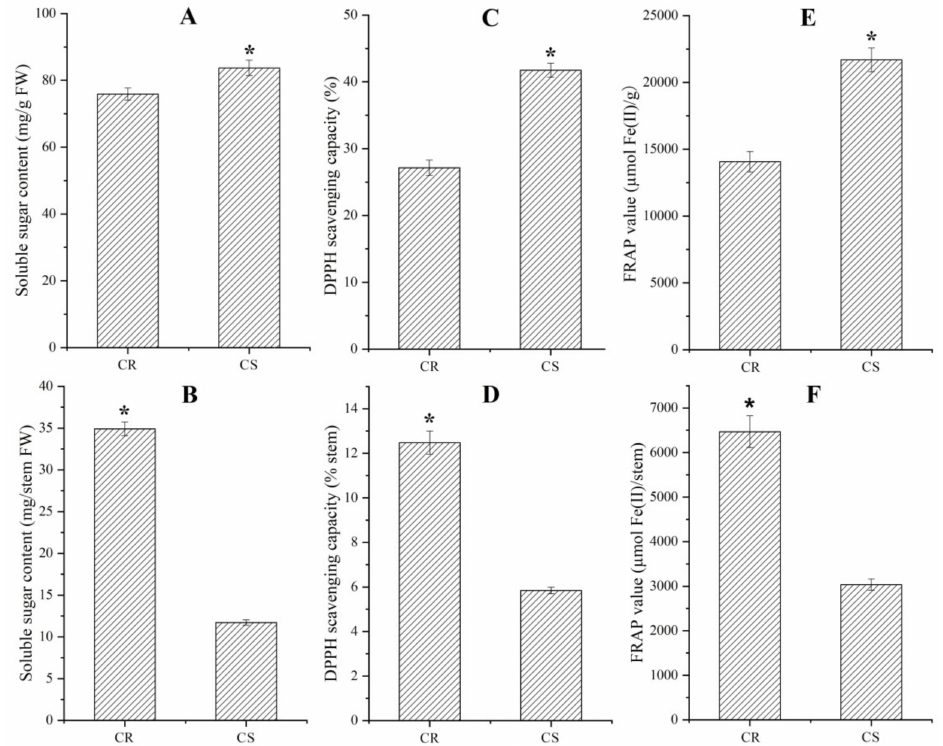
Figure 2. Soluble sugar content and antioxidant capacity in stems between the CR and CS (mean ± SD, n = 20). Images ( A – D ) as well as ( E , F ) represent soluble sugar content, DPPH scavenging activity as well as FRAP value on an FW and per stem basis, respectively. A t-test was applied for independent samples, the “*” is considered significant at p < 0.05 between CR and